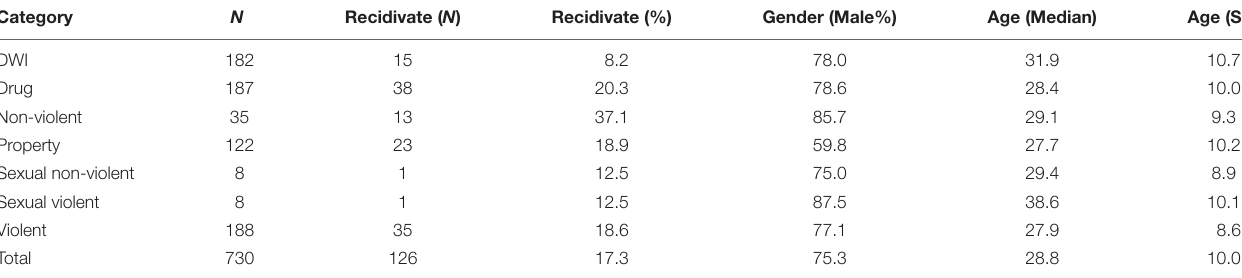
TABLE 3 | Self-reported race/ethnicity and number of previous arrests.